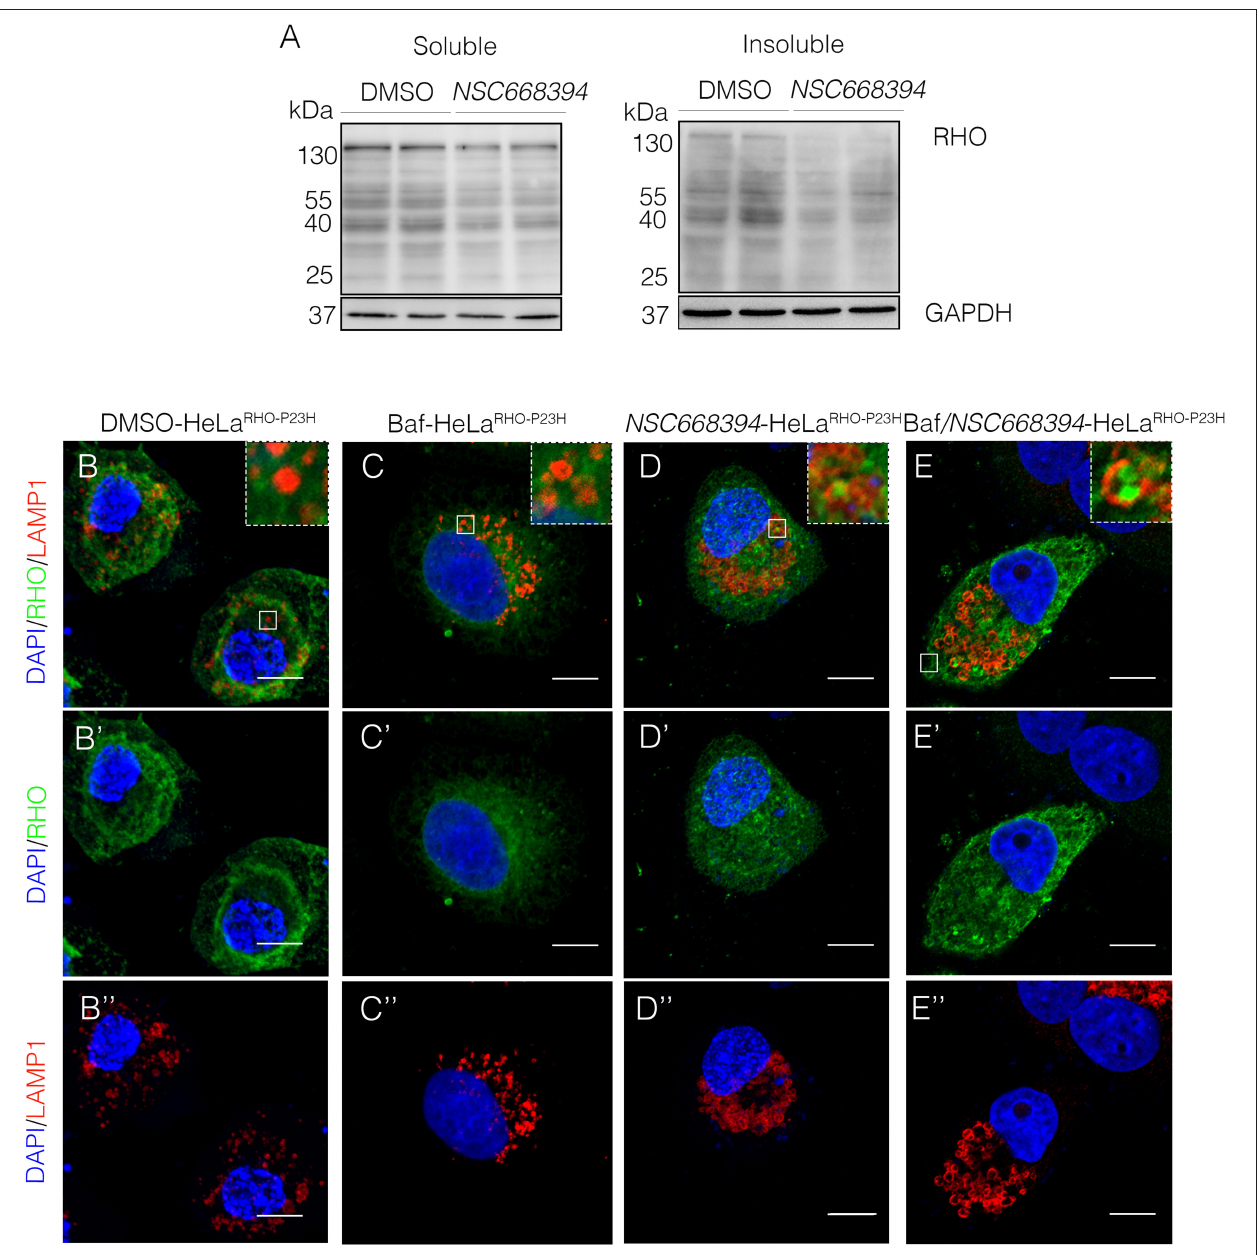
FIGURE 4 | The NSC668394 -treated HeLa RHO − P23H cells show an autophagy-related reduction of protein accumulation. (A) Representative Western blot analysis of RHO protein in the soluble and insoluble fraction of HeLa RHO − P23H cells treated with DMSO and NSC668394 . Representative images of HeLa RHO − P23H cells immunostained with anti-RHO and anti-LAMP1 from DMSO-treated (B − B”) , Baf-treated (C − C”) , NSC668394 -treated (D − D”) , and Baf/ NSC668394 -treated (E − E”) HeLa RHO − P23H cells. Nuclei are counterstained with DAPI (blue). Scale bar 10 µ m.